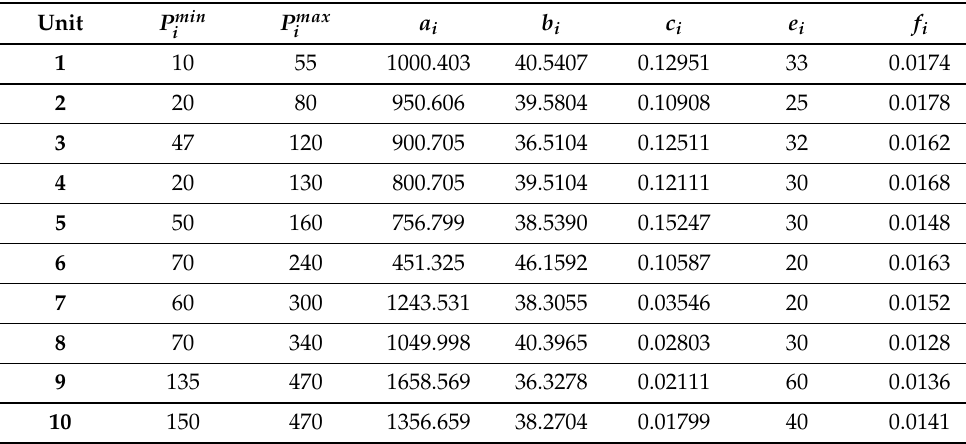
Figure 2. Communication topology graph for a ten-unit system. Table 2. Unit data for ten-unit system.